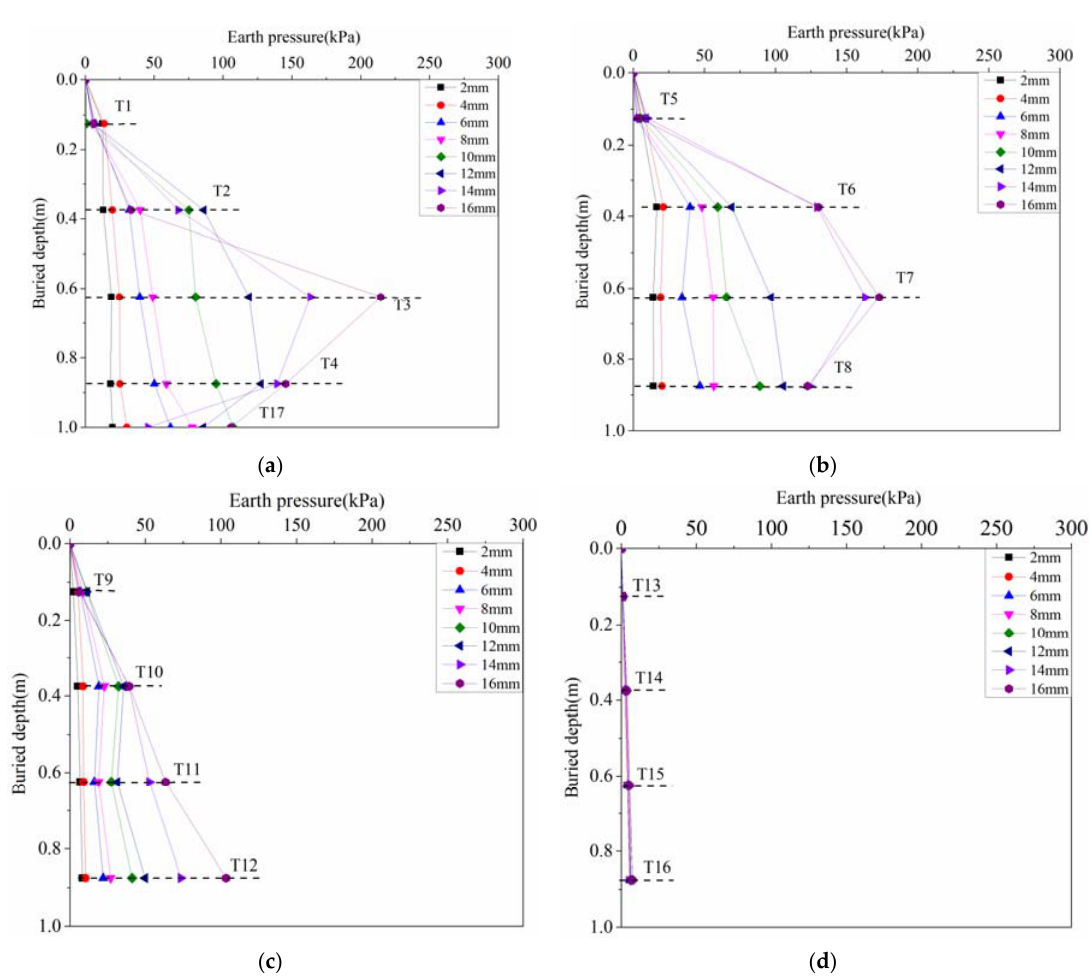
Figure 11. Distribution of passive earth pressure along the height of abutment. ( a ) Cells at the back face of the abutment. ( b ) Cells at horizontal distance of 0.2 H . ( c ) Cells at horizontal distance of 0.6 H . ( d ) Cells at horizontal distance of 1.4 H